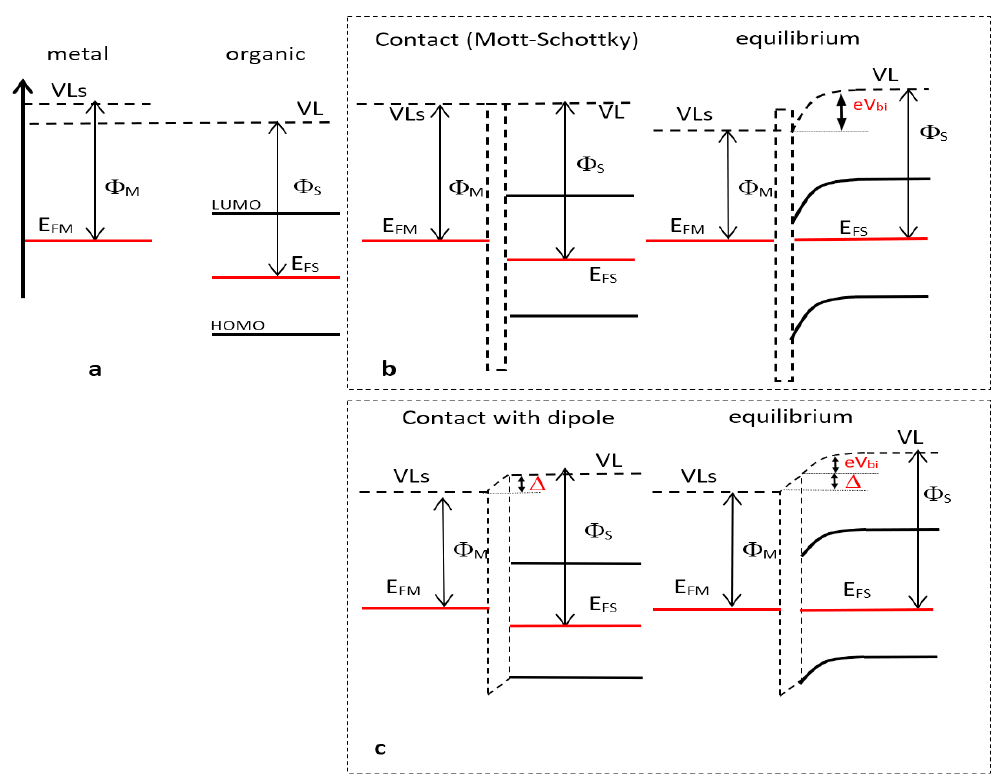
Figure 6. ( a ) Kelvin Probe Force Microscopy (KPFM) measurements of a metal and an organic layer Vacuum Levels (VL’s) for metal are higher than standard VL because of electron environment at surface); ( b ) contact (left) and electronic equilibrium (right) between the electrode and the organic layer according to the Mott–Schottky law; ( c ) contact (left) and electronic equilibrium (right) between the electrode and the organic layer in the case of interfacial dipole.